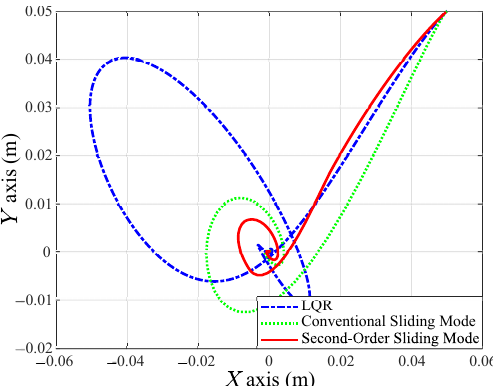
Figure 8. The simulation results compare the robot’s trajectory in the X - Y